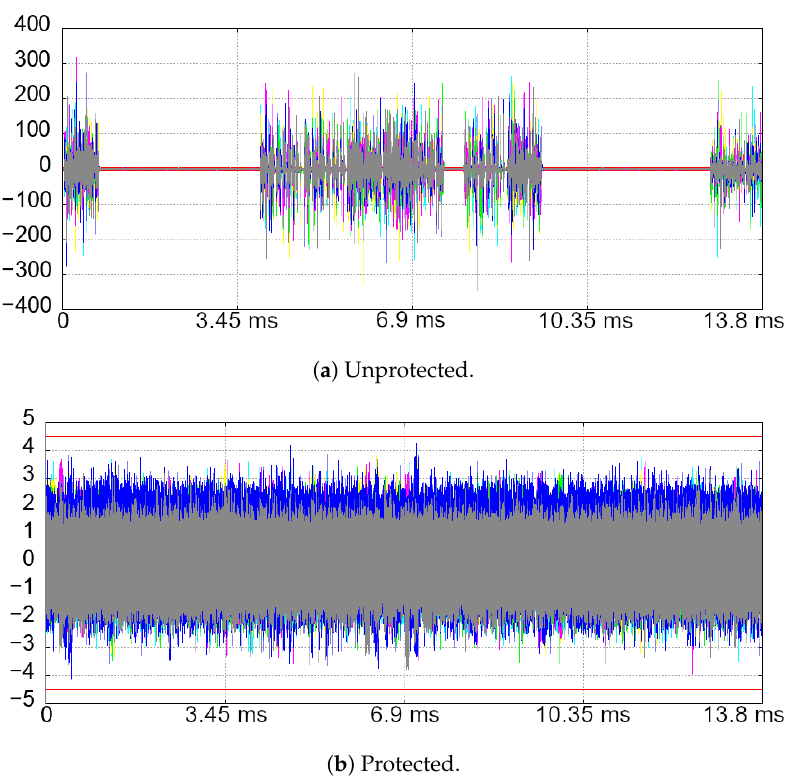
Figure 1. Results of the t-tests. Each graph contains six overlaid curves. The t-value is depicted on the vertical axis, and time is on the horizontal